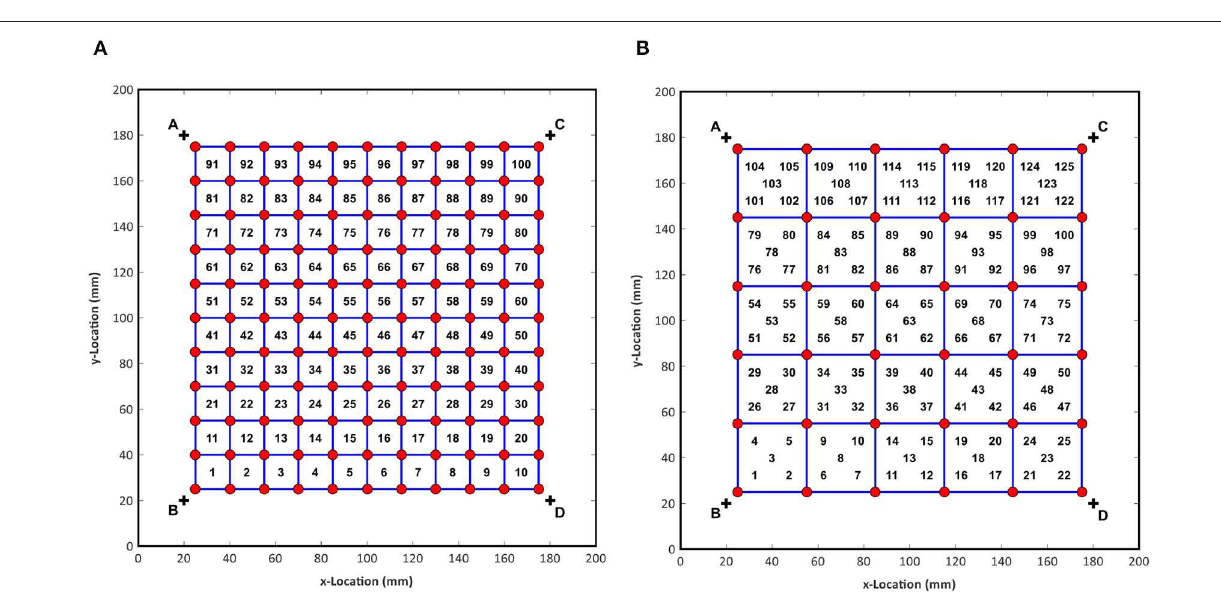
Pencil Drop Test and Grid Refinement The original baseline grid, in which each point pertains to a corresponding recorded impulse response, as shown in Figure 2B , relies on 121 points. In order to optimize the training process of the plate, a grid refinement factor of 2 was